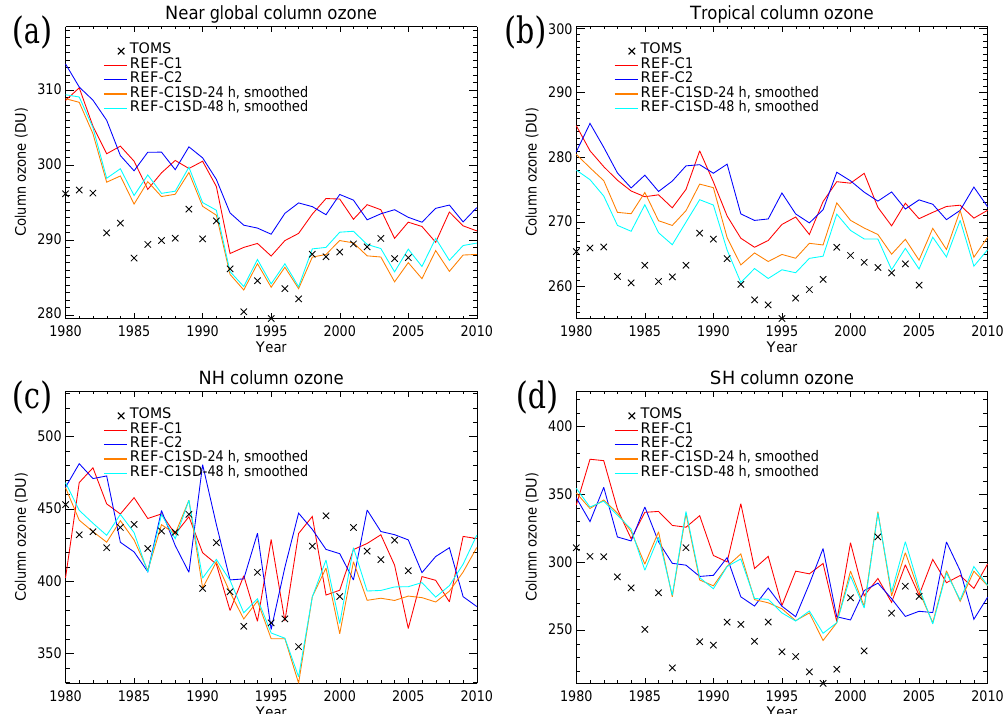
Figure 12. Total column ozone (TCO): (a) annual mean near global (60 ◦ S–60 ◦ N), (b) annual mean tropics (20 ◦ S–20 ◦ N), (c) Northern Hemisphere March (60–90 ◦ N), and (d) Southern Hemisphere October (60–90 ◦